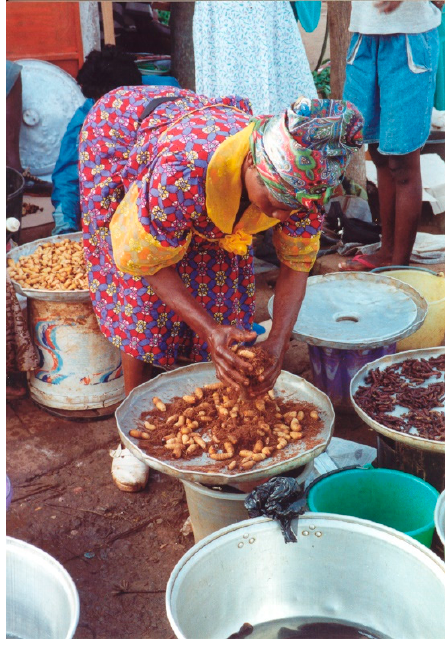
Figure 1. Selling the larvae of the African palm weevil Rhynchophorus phoenicis on the local market in Yaoundé, Cameroon (photo by author).